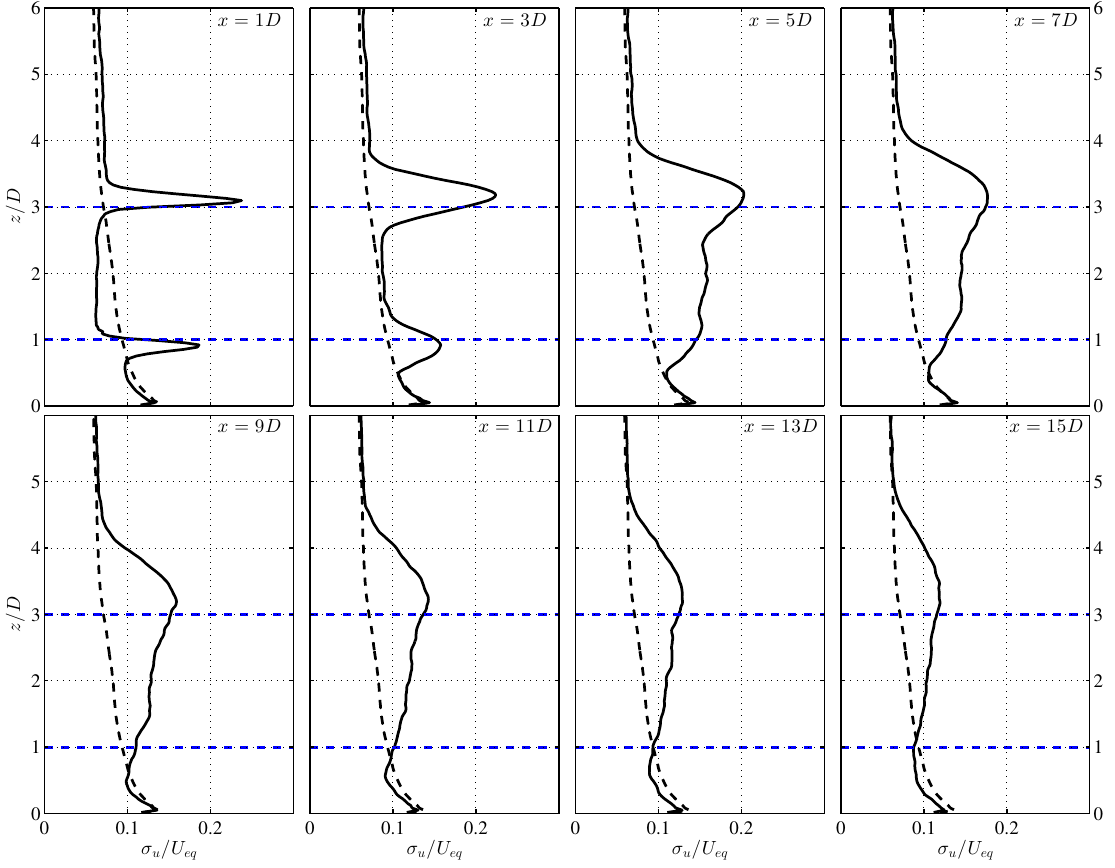
Figure 14. Vertical profiles of the streamwise turbulence intensity in the x - z plane going through the center of the turbine at different downstream positions. The black dashed line represents the inflow profile, and the blue horizontal dashed lines show the extent of the turbine.